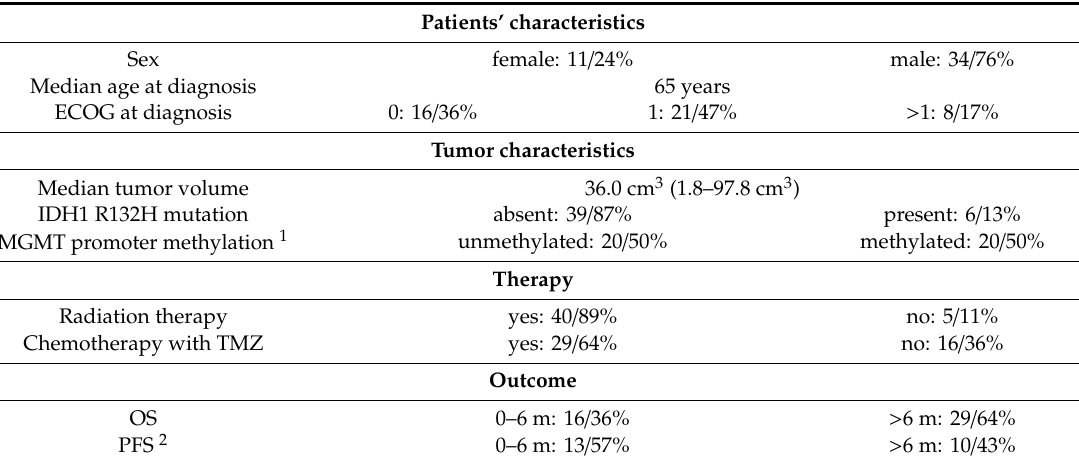
Table 1. Clinical parameters of tumor